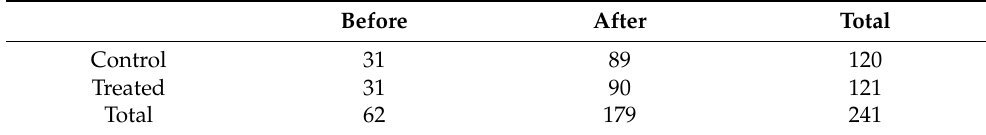
Table 1. The number of observations in the